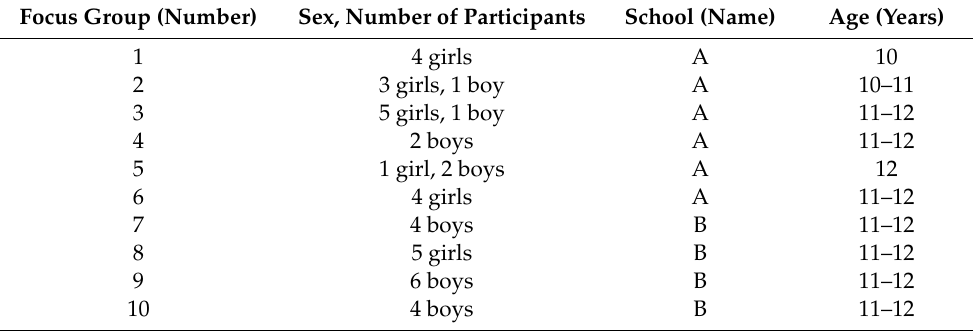
Table 1. Focus group, sex, school, number of participants, and